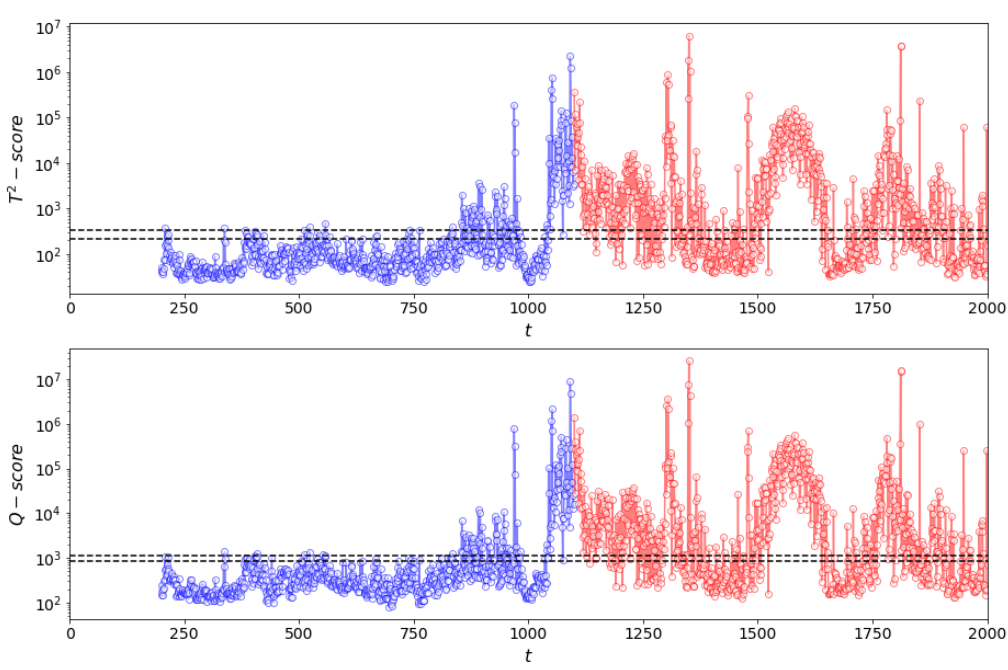
Table 7. Monitoring results on AG mill power draw using Method II.